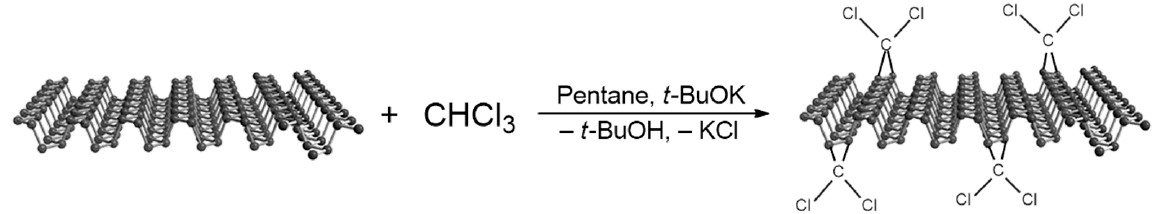
Figure 1. Schematic representation of BPNS functionalization with dichlorocarbene moieties. The morphological characteristics of the BPNS before and after functionalization were determined by scanning electron microscopy (SEM), transmission electron microscopy (TEM), and atomic force microscopy (AFM) methods. As shown in the AFM and TEM images (Figure 2), the exfoliated BP particles exhibit sheet-like morphology with uniform thickness and lateral size ranging from 100 to 600 nm. The thickness of BPNS estimated by the AFM method varied from 3 to 4 nm, which corresponds to 5–7 phosphorene